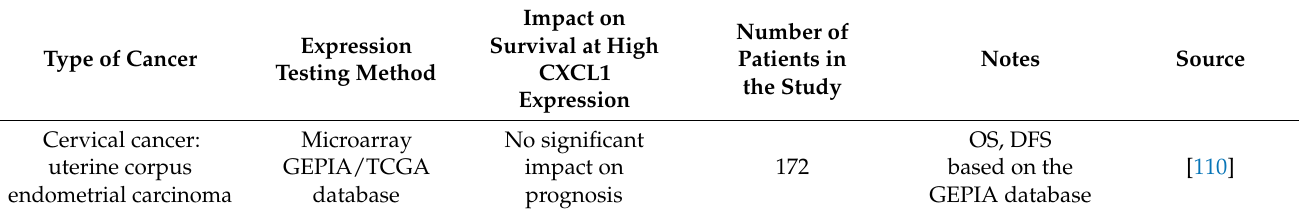
Table 3. Effect of CXCL1 expression level on survival of endometrial cancer